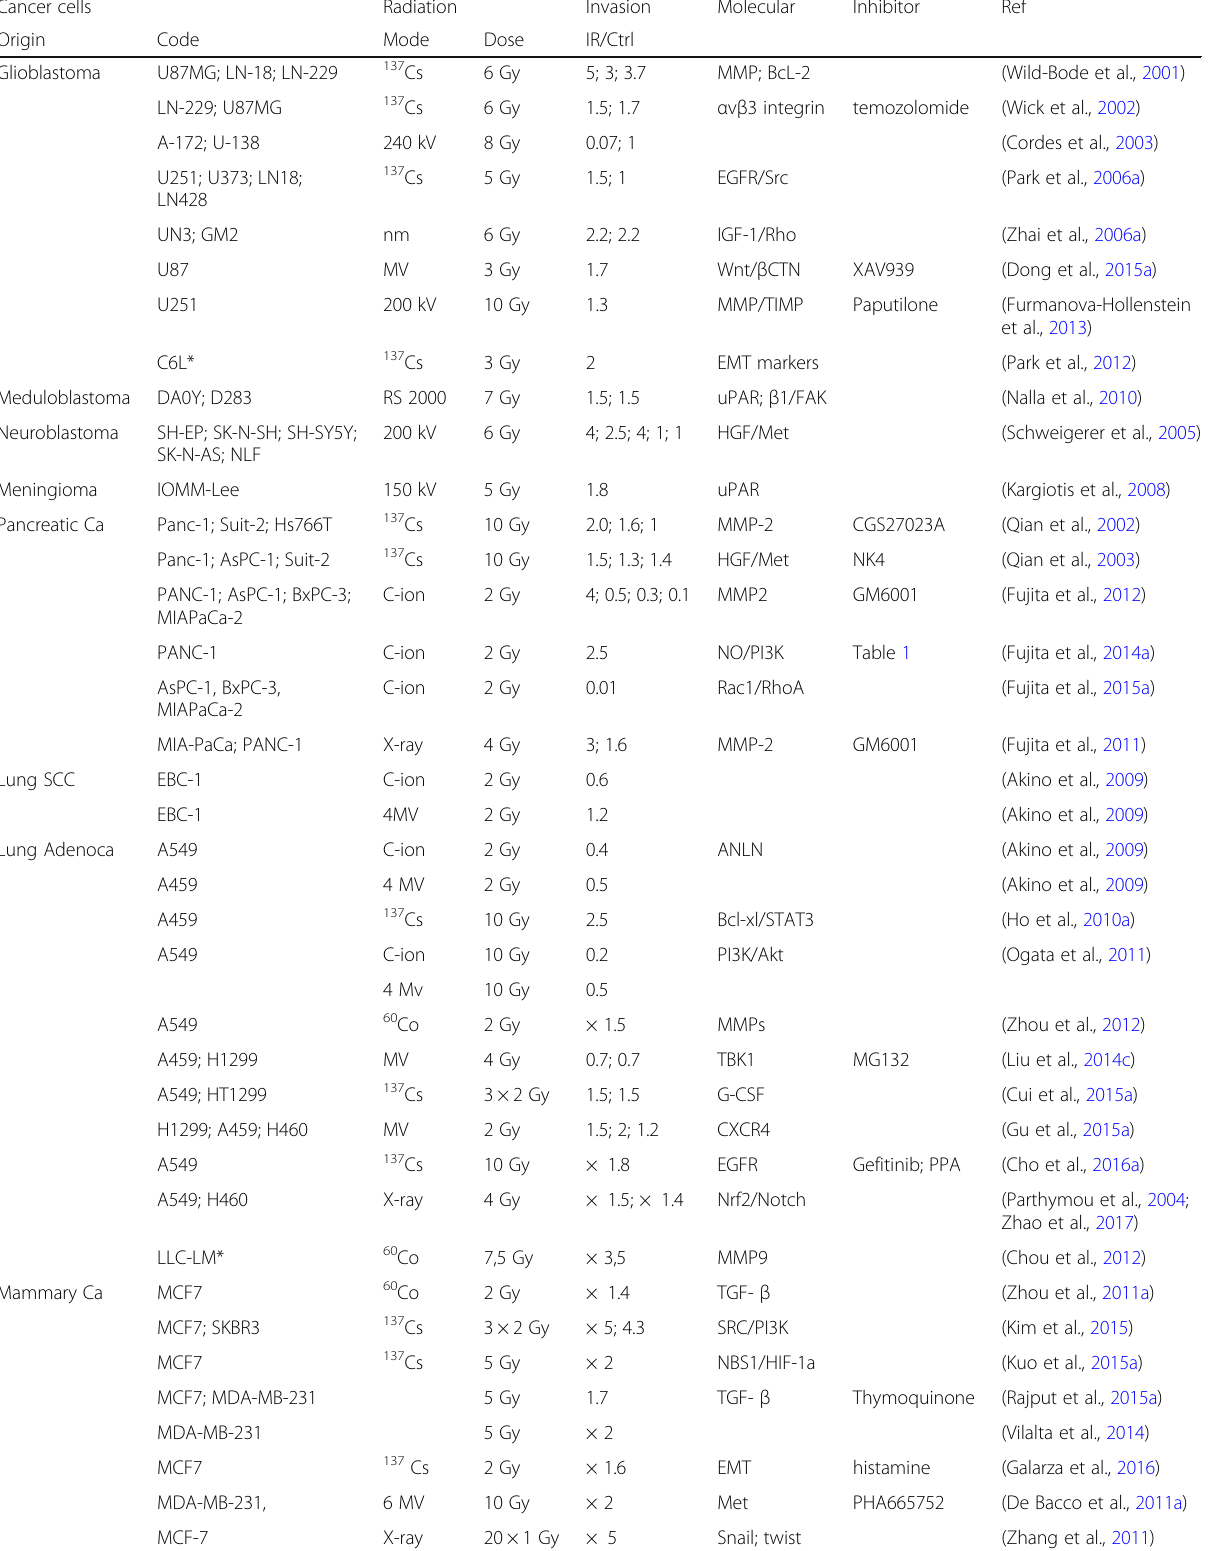
Table 2 Effect of radiation on the invasion of cancer cells in Matrigel-coated two-compartment chambers in